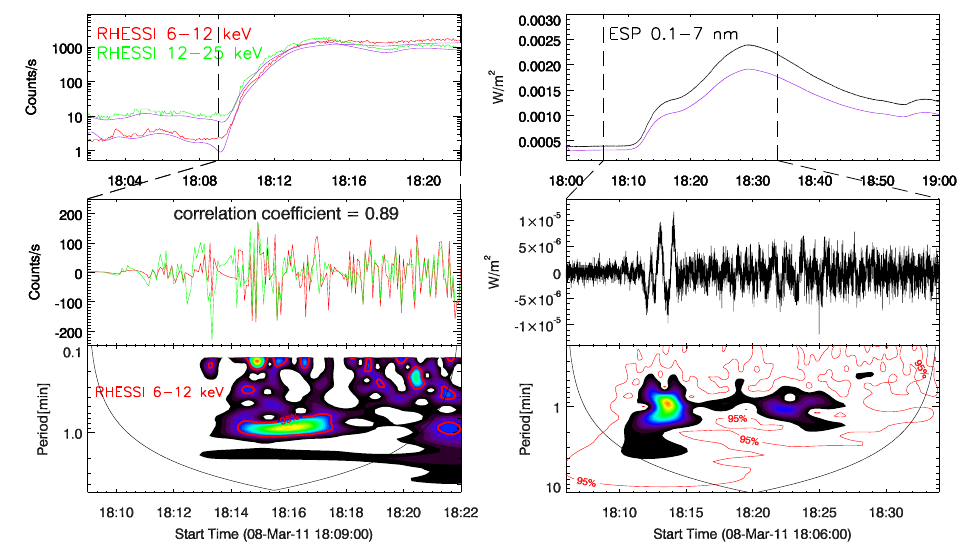
Figure 2. Top panels: the light curves of RHESSI at 6–12 keV (red) and 12–25 keV (green), and SDO/EVE ESP at 0.1–7 nm (black), their slowly-varying components (purple, already multiplied by 0.8). Middle and bottom panels: the fast-varying components and their wavelet spectra. The correlation coefficient between the fast-varying components of RHESSI 6–12 keV and 12–25 keV is given. The red contours represent a significance level of